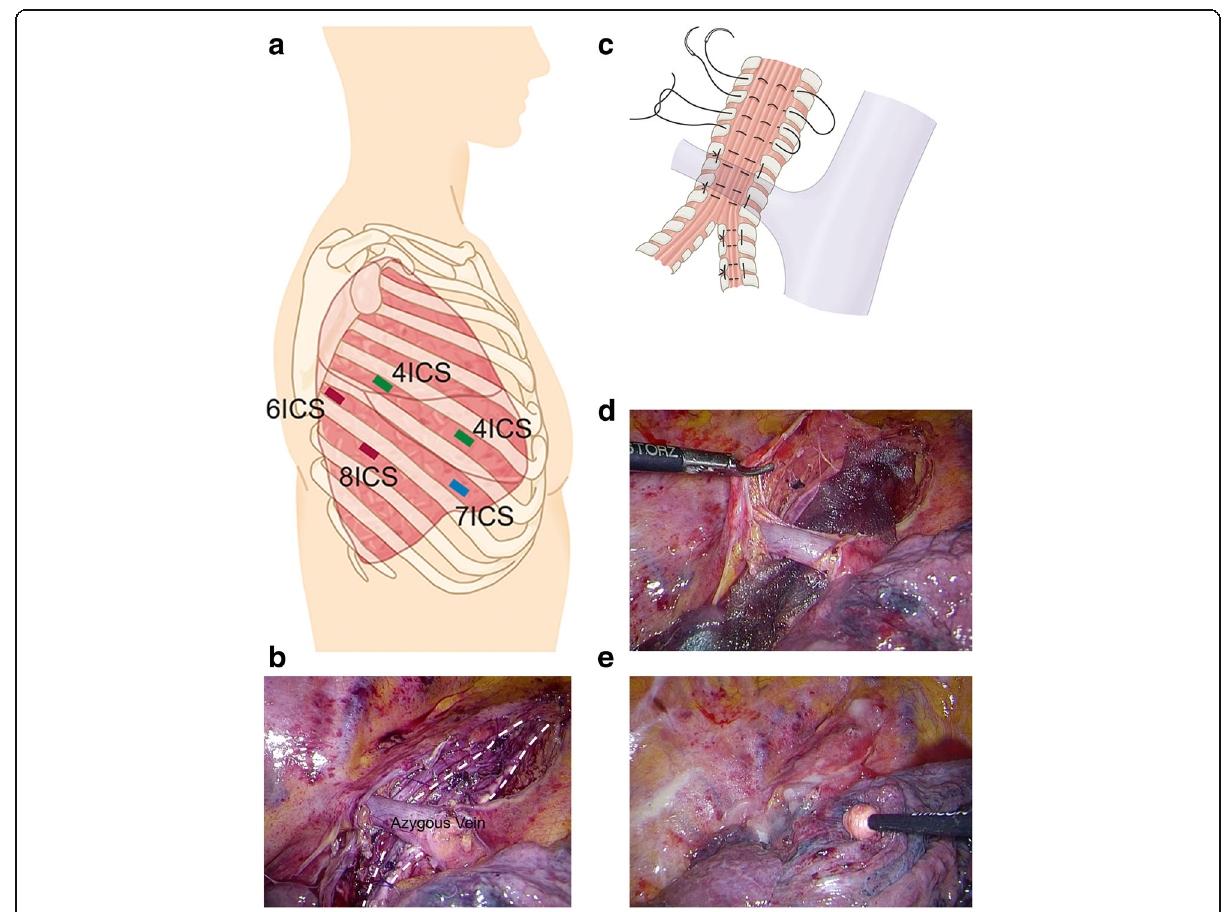
Fig. 2 Surgical technique. a Schema of port sites in this surgery. b Plicated tracheal and right main bronchial membranous portion using the horizontal mattress suture technique with 4-0 PDS double-ended needles (within dotted line). c Schema of the plication technique. d Polyglycolic acid sheets on the sutured portion, fixed with fibrin glue. e The plicated portion covered with the mediastinal